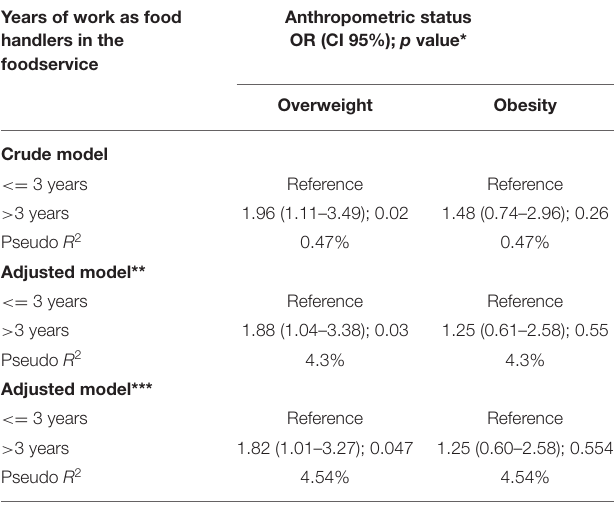
TABLE 3 | Relationship between years of work of food handlers in the foodservice and anthropometric status in workers of community restaurants. Years of work as food handlers in